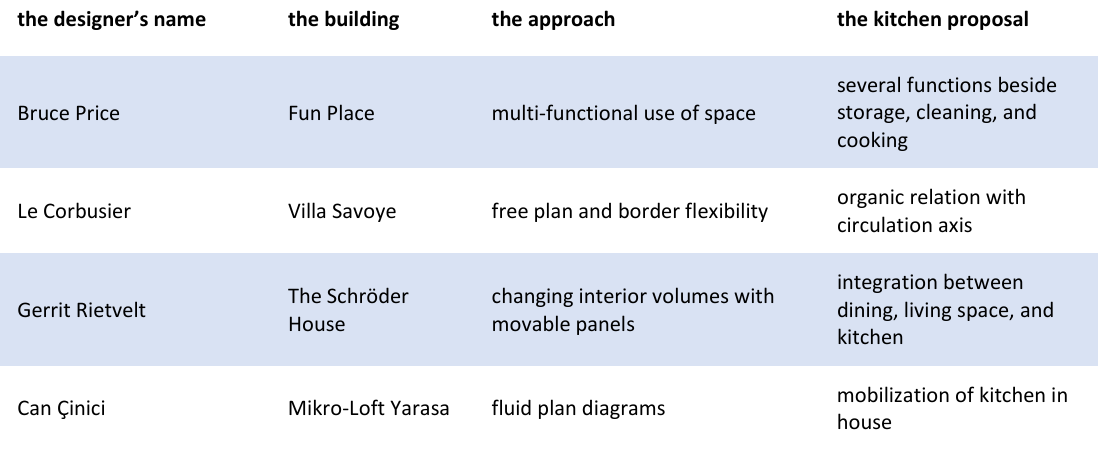
Figure 1 Flexibility approaches and kitchen interpretations in the sample buildings of the designers (Barışık, 2019; Asımgil & Durmuş, 2021)